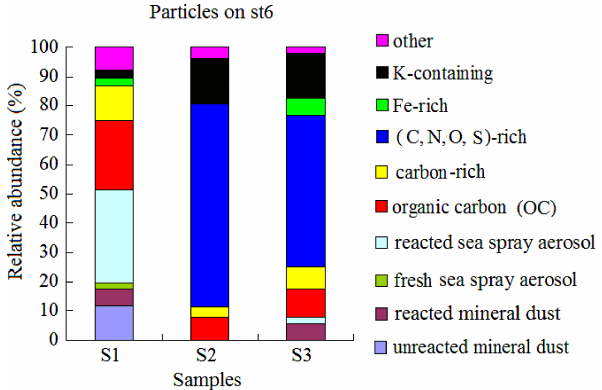
Fig. 8. Relative abundance percentages of various types of particles on stage 6 in samples